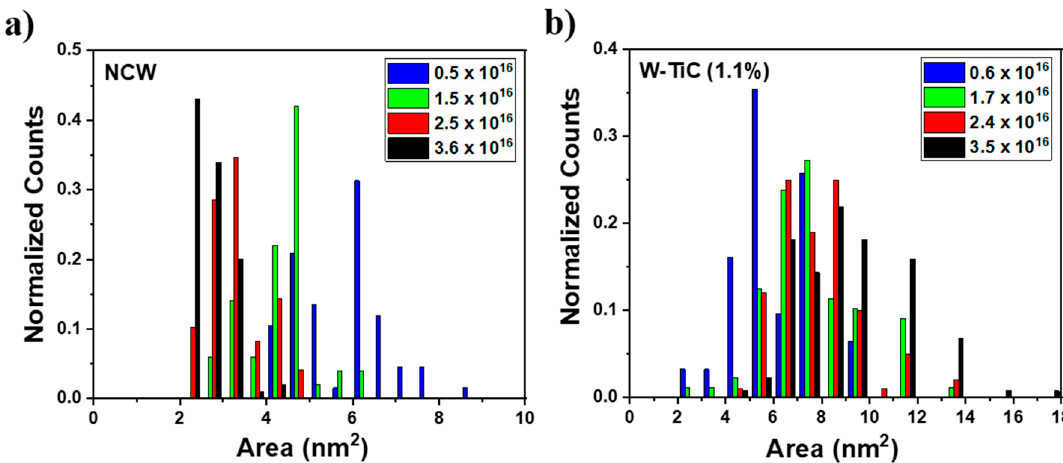
Figure 5. (Color online) normalized bar graphs of bubble size distributions in the grain matrices in ( a ) NCW and ( b ) W-TiC as a function of implantation He + fluence. (For interpretation of the references to color in this figure legend, the reader is referred to the web version of this article.)